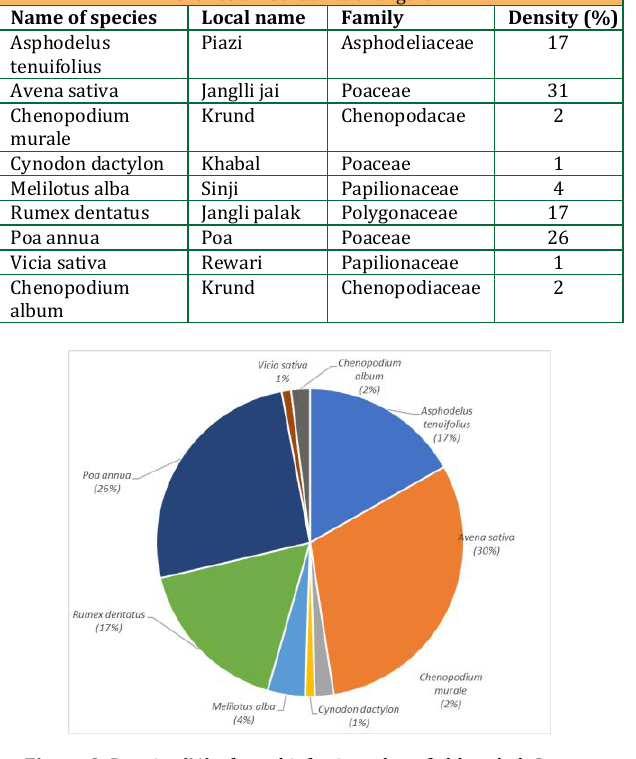
Table 8: Density (%) of weed infesting wheat field at chok Sarwar Shaheed District Muzaffargarah Name of species